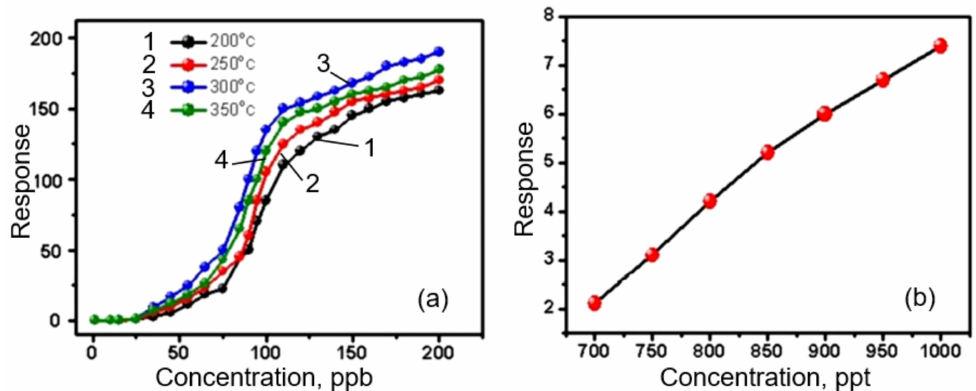
Figure 4. ( a ) Response of pure TiO 2 single nanofiber triangular sample in the presence of CO gas as a function of concentration at 200 − 350 ◦ C. ( b ) The response of TiO 2 :Au triangular samples in the presence of CO gas as a function of concentration in ppt range at 250 ◦ C. Reprinted with permission from [86]. Copyright 2017 ACS.